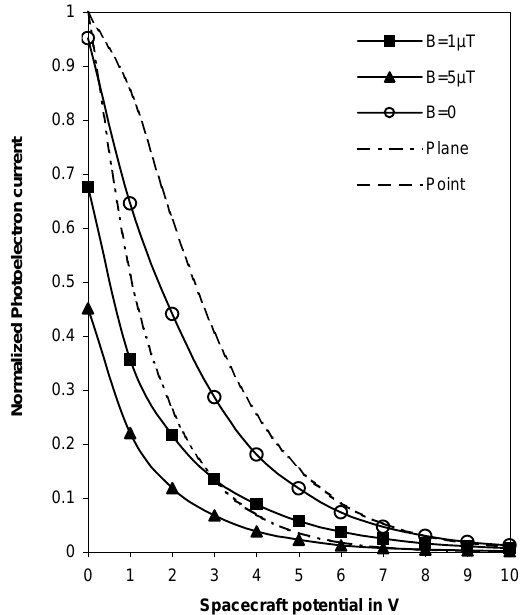
Fig. 7. Normalized photoelectron current-voltage characteristics for B 0 = 1 µ T and different values of the angle α between B 0 and the x − y plane: α = − 30 ◦ (dotted curve), α = 0 ◦ (solid curve) and α = 30 ◦ (dashed